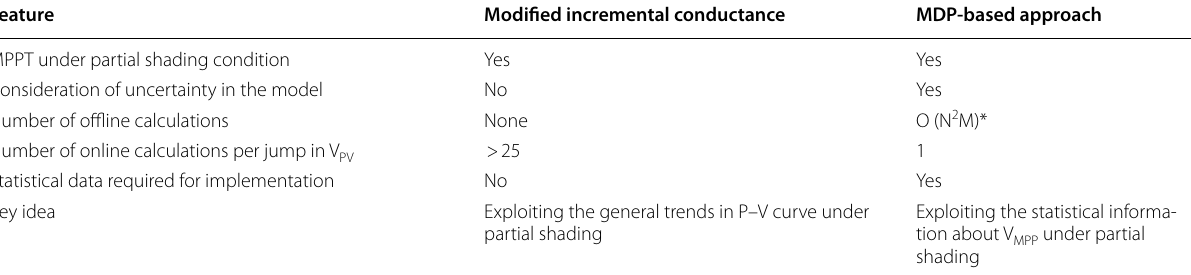
Table 5 Comparison of MDP with MIC